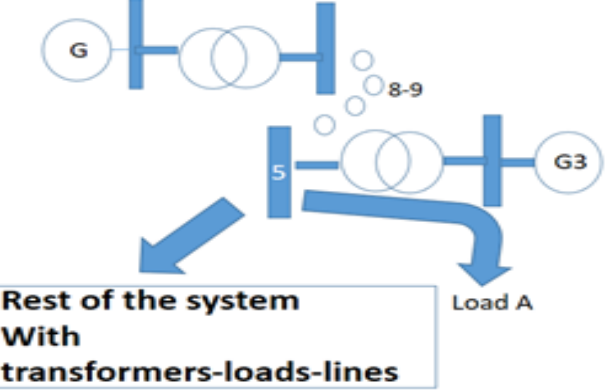
Figure 4. IEEE 9-bus conceptual system.